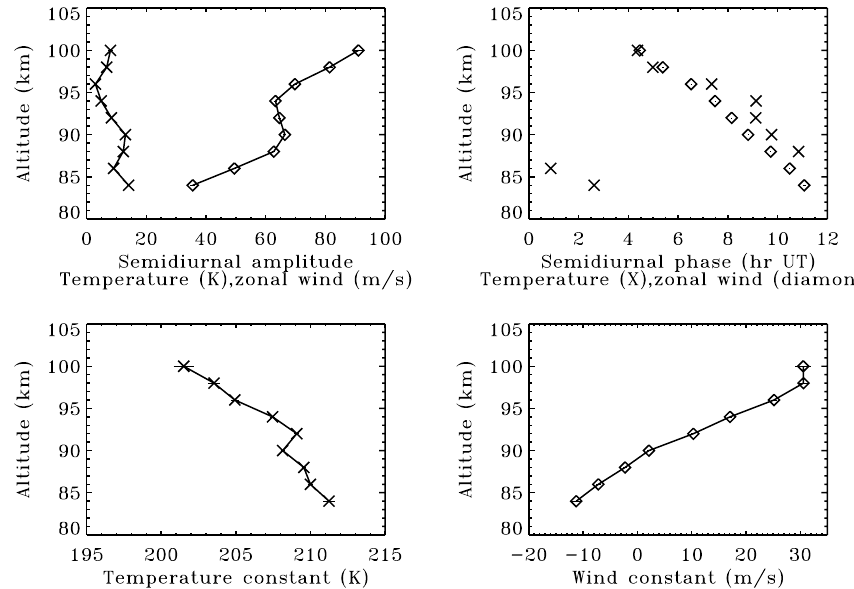
Fig. 3. Semidiurnal amplitude, phase, and constant for zonal wind and temperature on 28 January 2003. Note how the zonal wind amplitude increases with height and the temperature amplitude decreases with height. The phase difference between zonal wind and temperature goes from over 3h at 84km to near zero above 95km. The mean wind and temperature profiles have a simple structure and relatively small